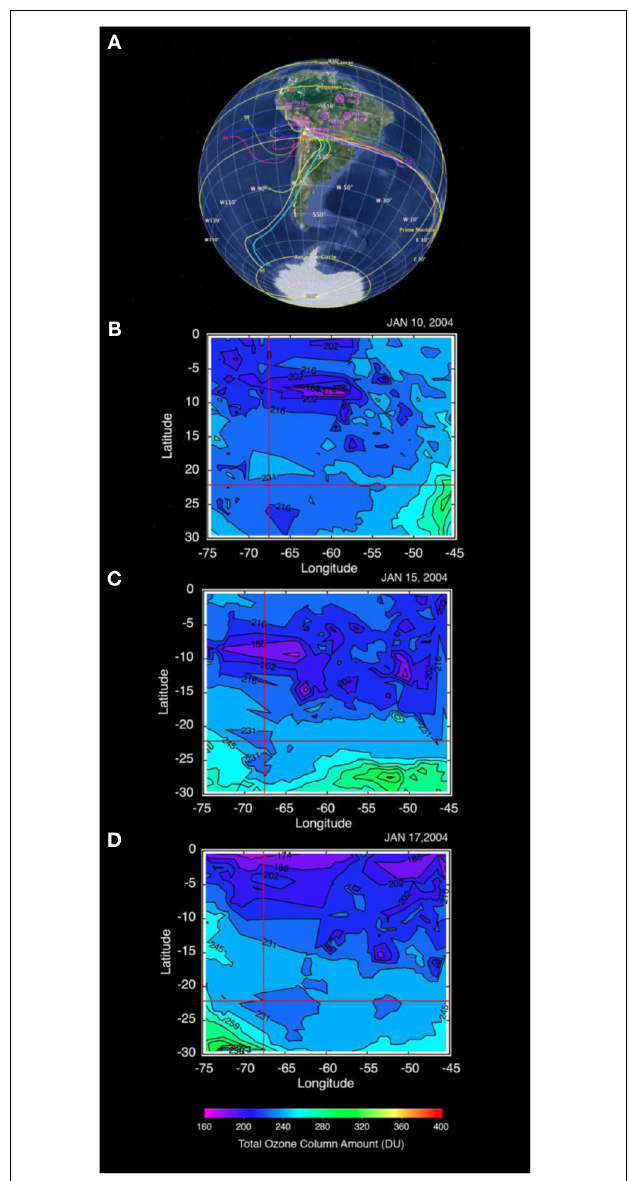
FIGURE 4 | Trajectory reconstruction and NOAs. (A) Backward trajectories of air at 500 to 5hPa atmospheric pressure levels ( ∼ 6 − 36km asl) over the sites on January 17, 2004 at 14:30 UTC (9:30am local). Starting points of the trajectories are seven days prior arrival. Three NOAs directly connect with the path of the stratospheric (100, 50, and 5hPa) and mid-tropospheric (500hPa) trajectories; (B–D) Daily ozone maps for tropical South America showing the status of the ozone in the atmosphere at the time of the UV spikes of January 10, 15, and 17, 2004. The intersection of the two red lines mark the position of the sites. Ozone data—AIRS and